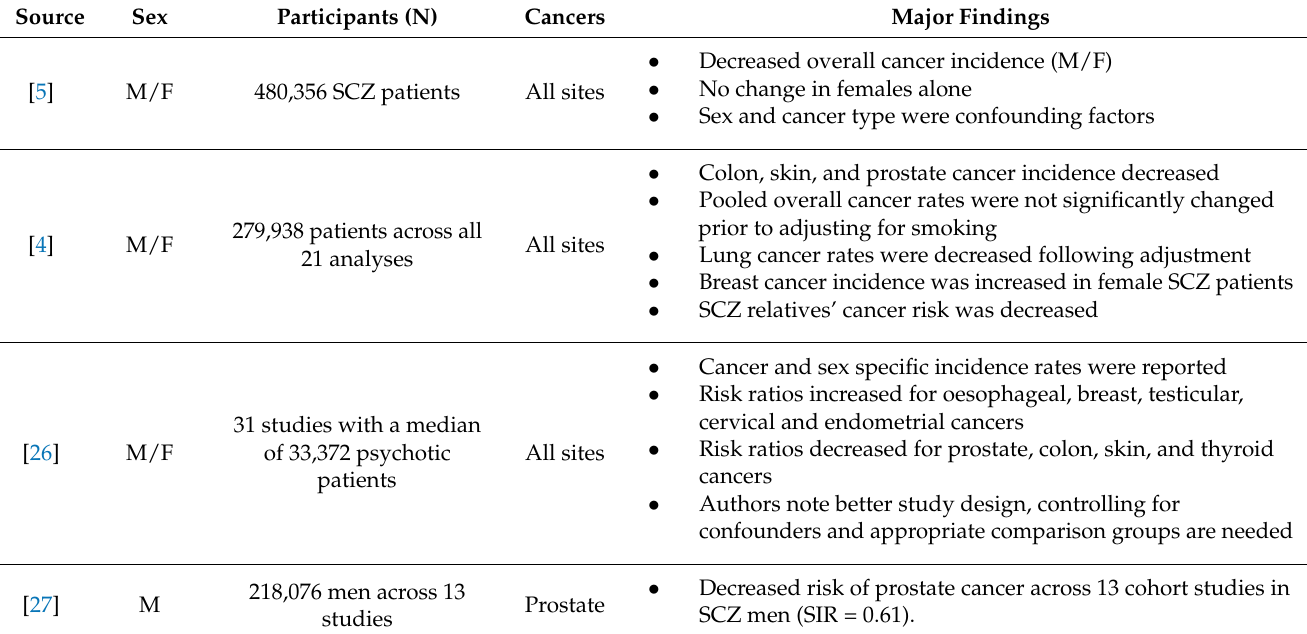
Table 1. Review of Meta-analyses examining cancer rates in schizophrenia